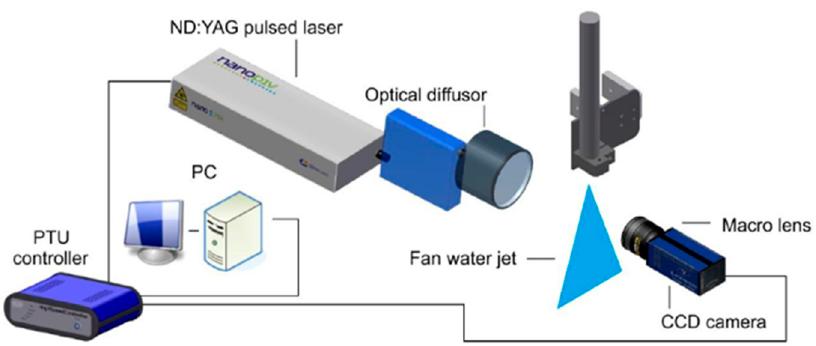
Figure 9. Schematic of experimental apparatus.